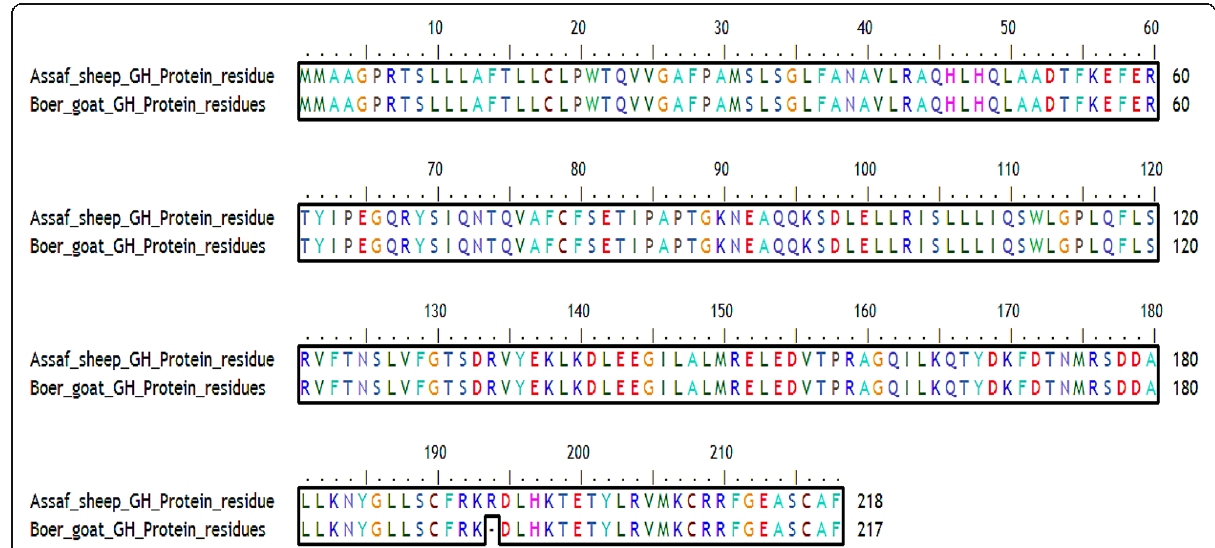
Fig. 18 Pairwise alignments of As_GH and Bo_GH protein